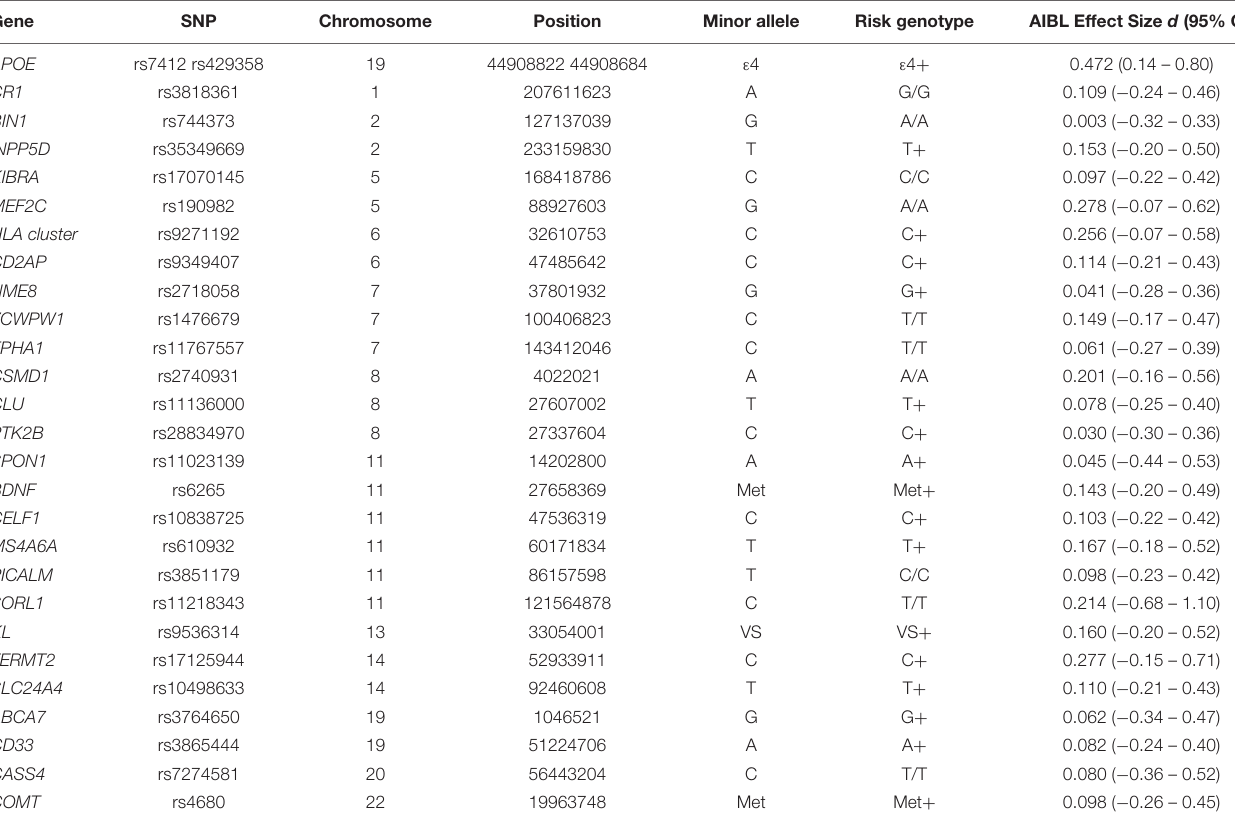
TABLE 1 | Single nucleotide polymorphisms (SNP)